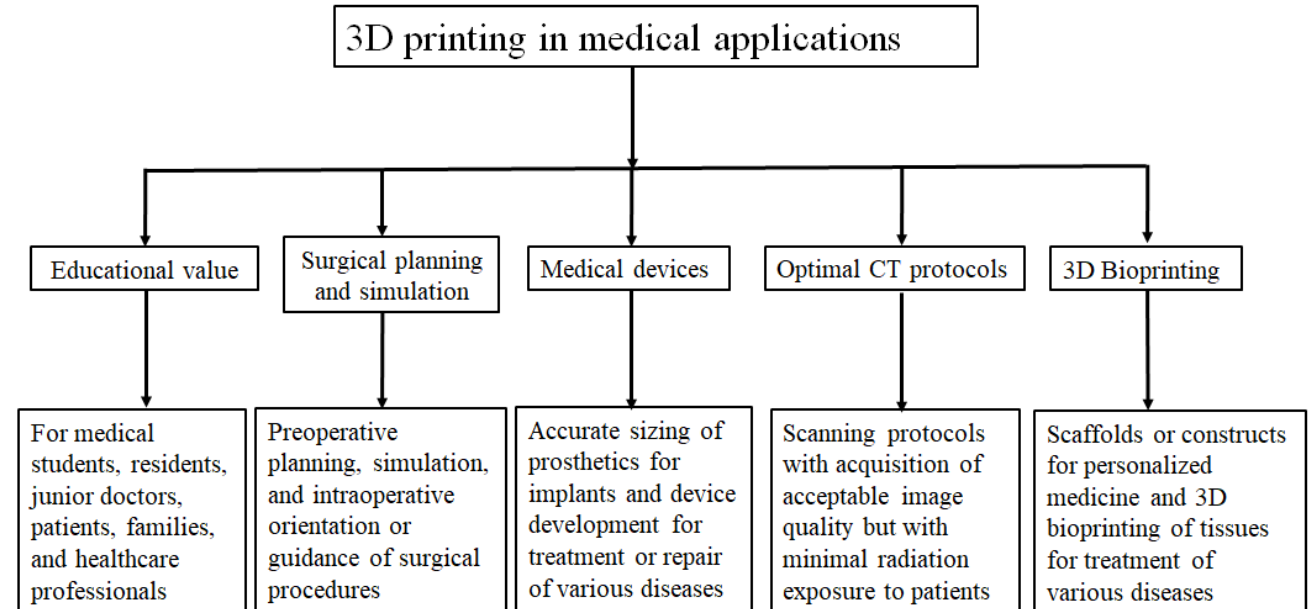
Figure 1. Summary of current medical applications of 3D-printed models. Adapted from Sun et al. [32]. et al.